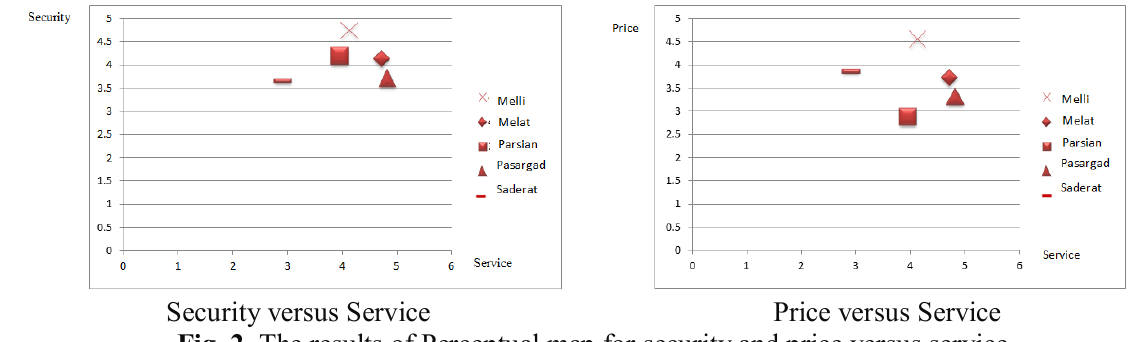
Fig. 2. The results of Perceptual map for security and price versus service